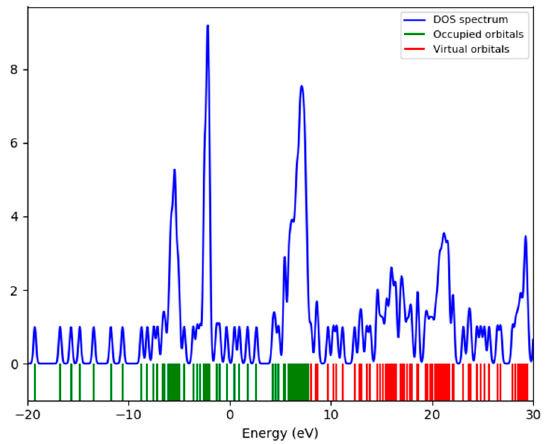
Figure 13. The DOS spectrum of (C 6 H 8 Cl 2 N 2 ) 2 [Cd 3 Cl 10 ] · 6H 2 Figure 13. TheDOS spectrum of(C 6 H 8 Cl 2 N 2 ) 2 [Cd 3 Cl 10 ]·6H 2 O.